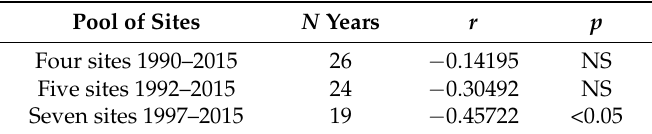
Table 10. Spearman rank correlations of trend (abundance vs. year) in median abundance of pools of sites monitored each year during the period (Figure 10). NS = not significant ( p >